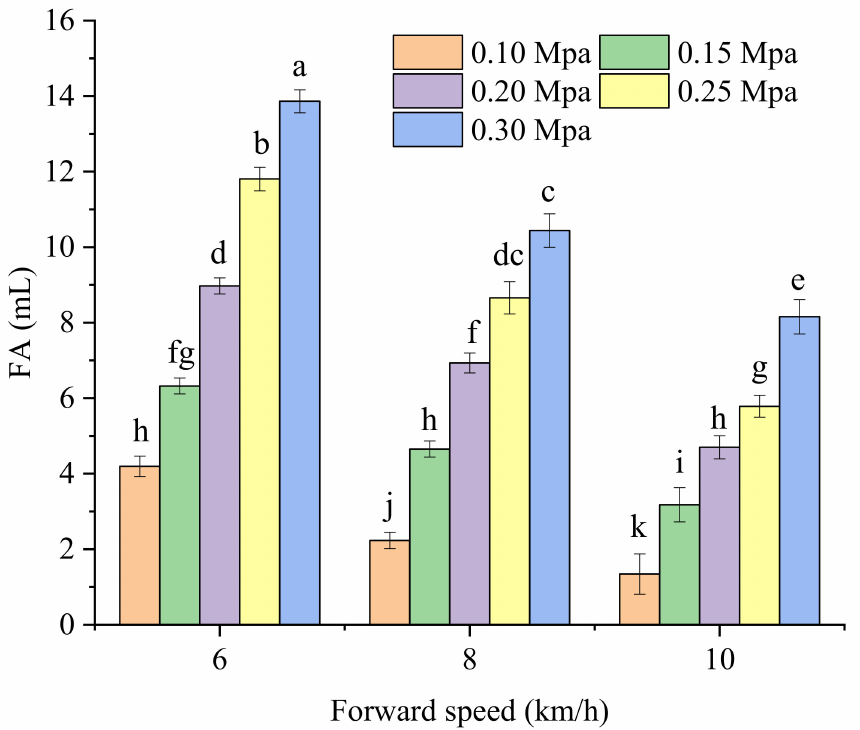
Figure 14. The amount of liquid starter fertilizer (FA) of different treatments. Only the values that are each denoted by different letter(s) ( a – k ) differ significantly at p <